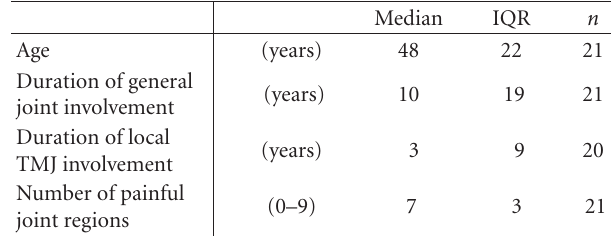
Table 1: Demographic data for 21 female patients with chronic inflammatory temporomandibular joint (TMJ) disorders subjected to intra-articular glucocorticoid injections. The patients were asked about pain in nine joint regions besides the TMJ (neck, shoulders, elbows, hands, upper back, lower back, hips, knees, and feet) and the number of painful joint regions was recorded (score = 0–9), IQR = 75th–25th percentile, n = number of